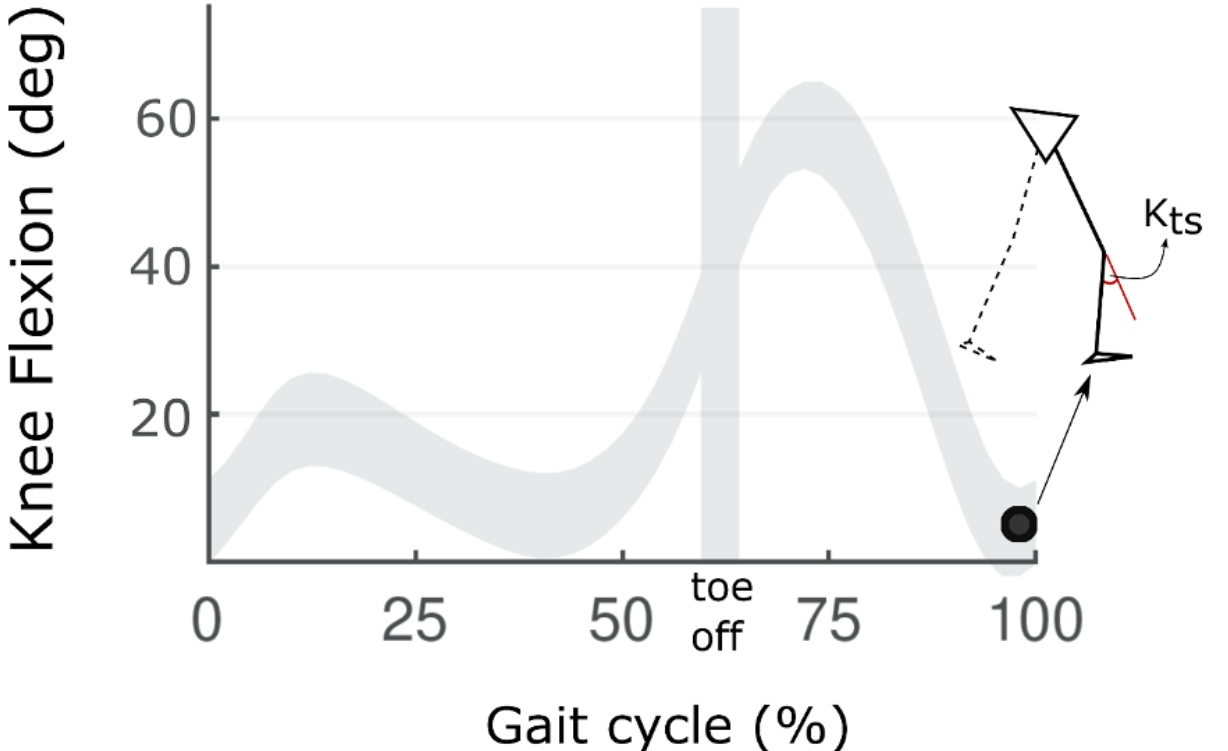
Figure 2. Knee flexion angle at the end of the swing phase during walking (K ts ).